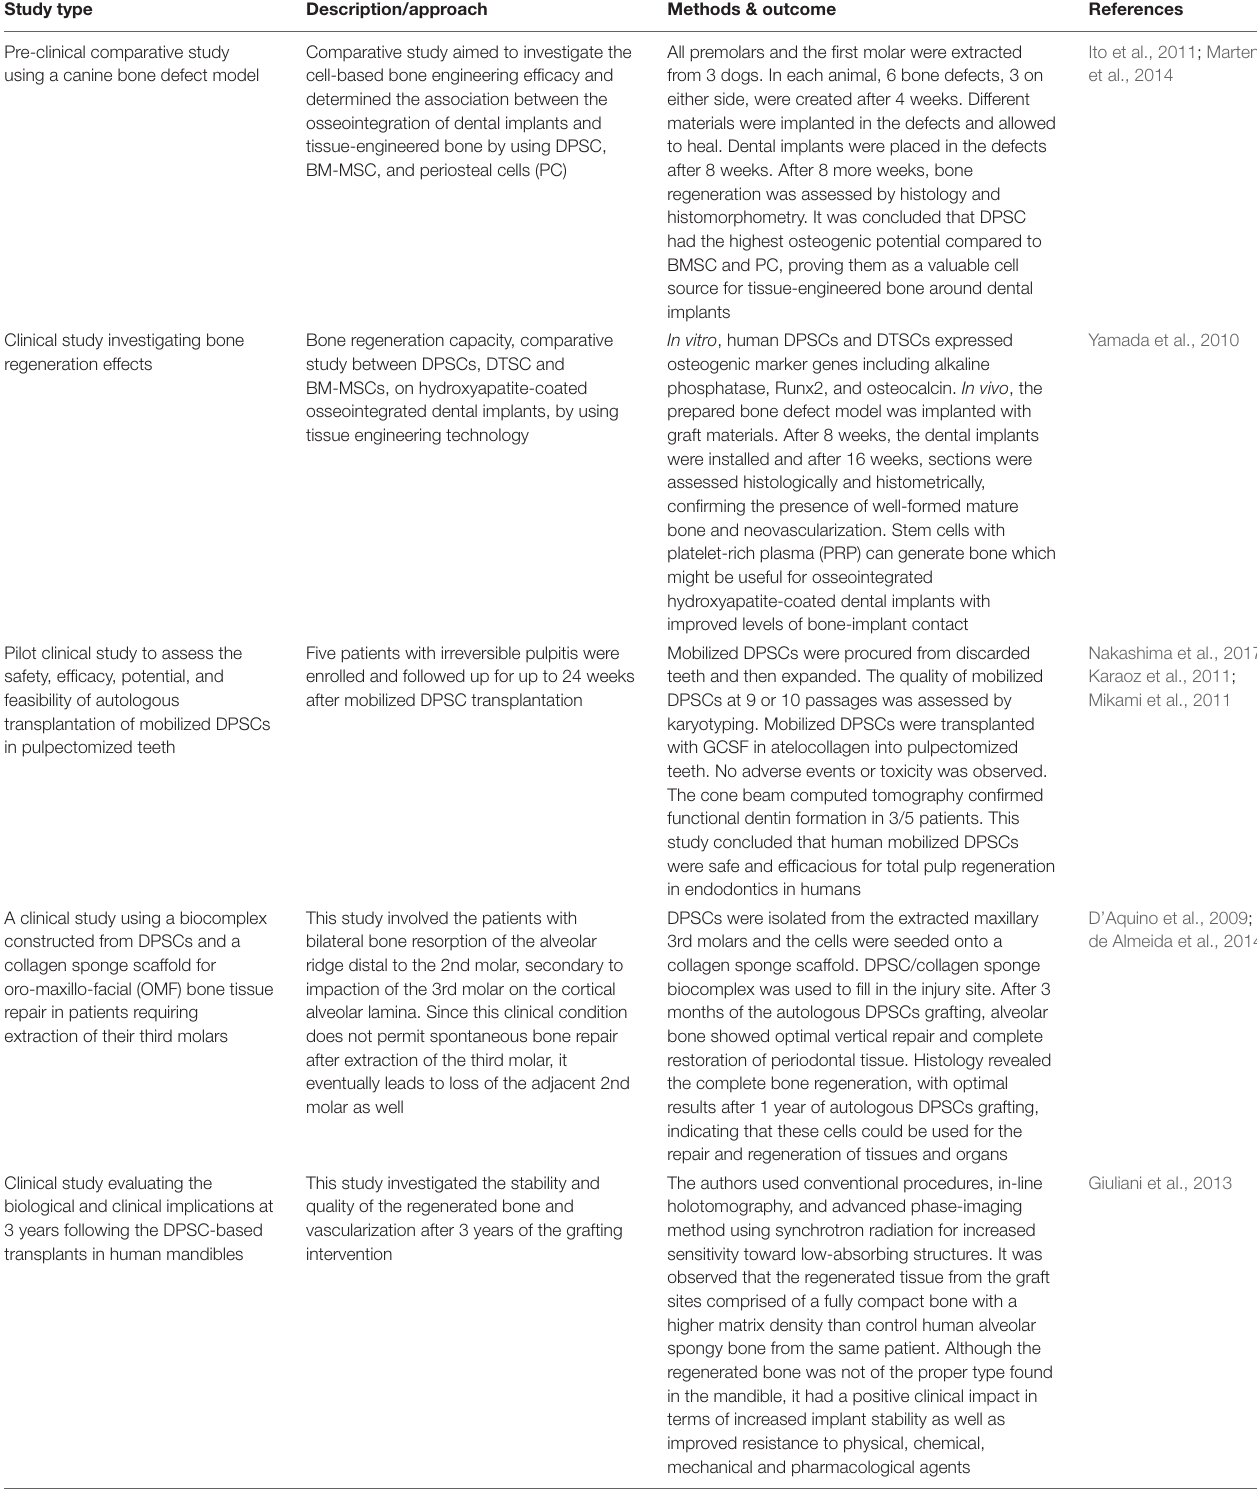
TABLE 4 | Pre-clinical/clinical studies involving use of human